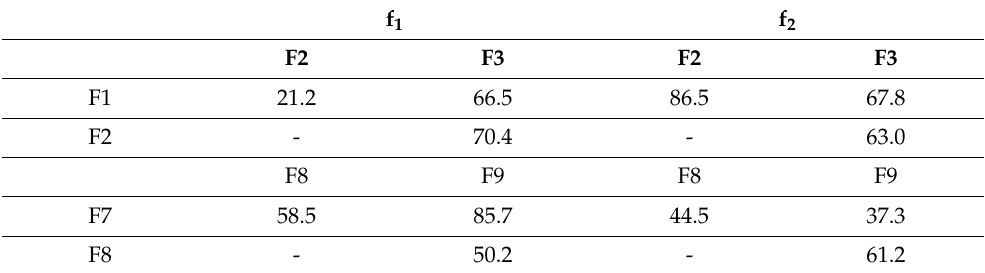
Table 5. The calculated values of the difference factor f 1 and the similarity factor f 2